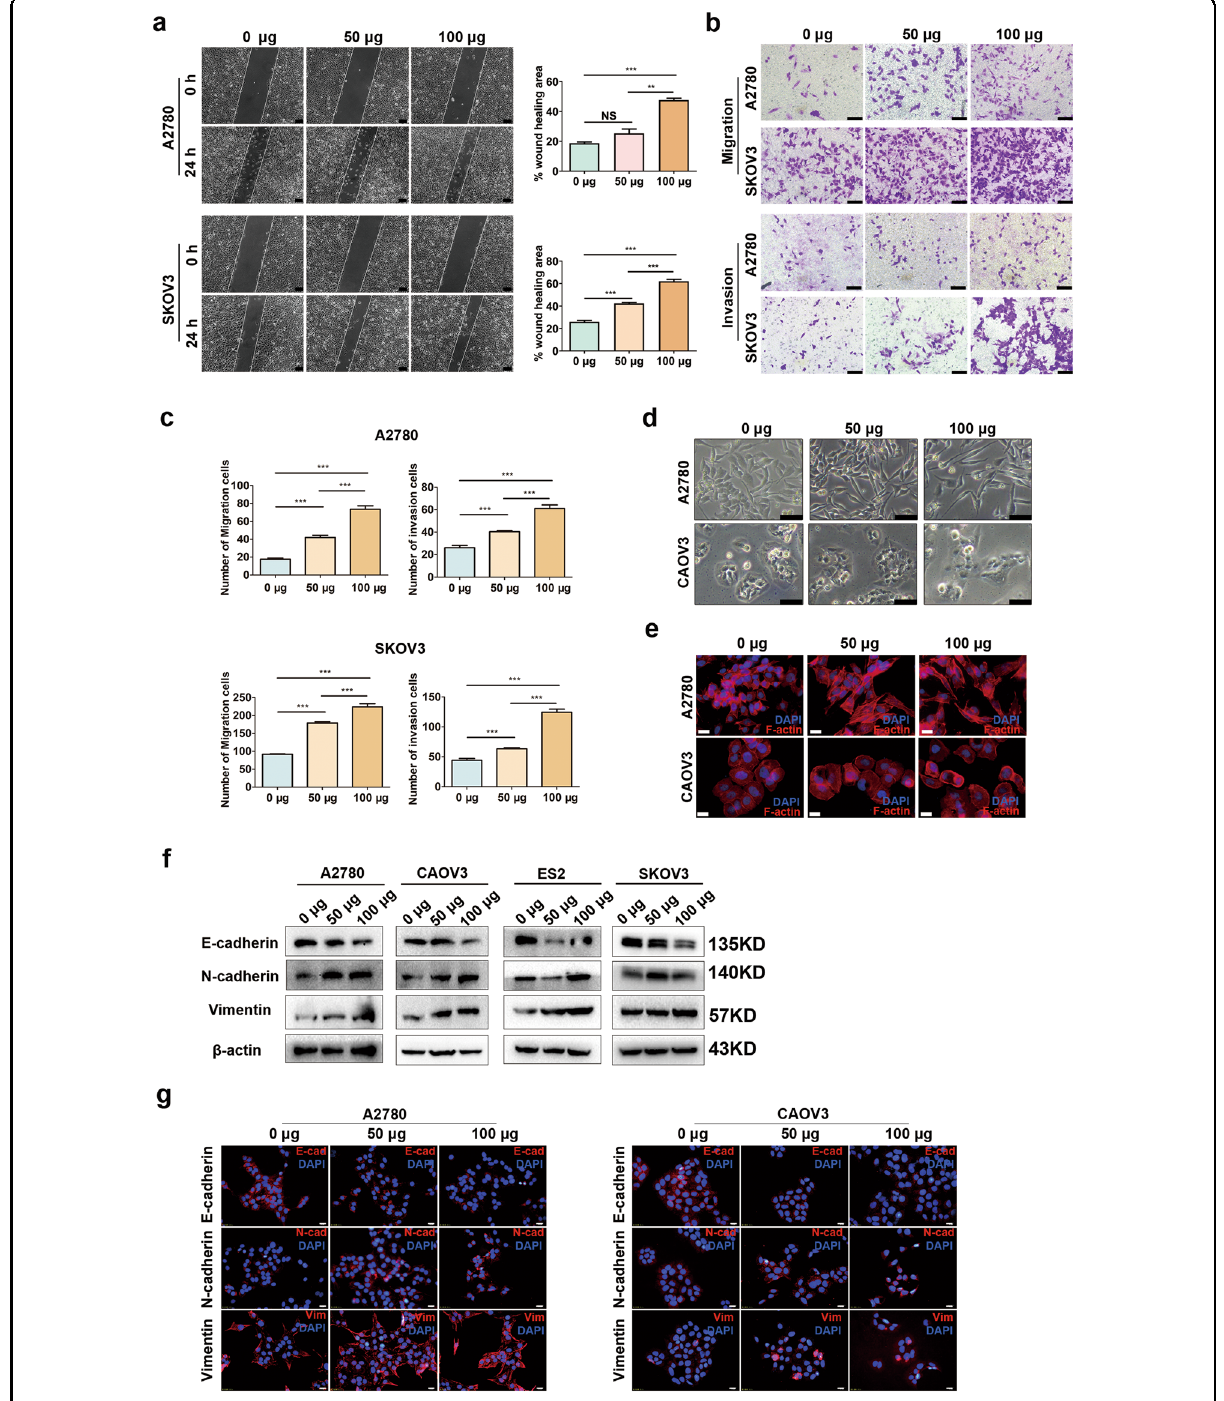
Fig. 2 ADEs promote EMT of ovarian cancer cells in vitro. A2780, CAOV3, ES2 and SKOV3 ovarian cancer cells were treated with 0 μ g, 50 μ g, and 100 μ g of #7 ADEs. a Representative images of wound-healing assays of A2780 and SKOV3 and the area of wound closure was measured. Scale bar, 100 μ m. b Representative images from migration and invasion assays of A2780 and SKOV3 cells. Scale bar, 100 μ m. c Invaded and migrated cells were counted and are shown as histograms. d , e Changes in the morphology of A2780 and CAOV3 cells were evaluated by microscopic observation and F- actin staining. Scale bar, 100 μ m ( d ), Scale bar, 20 μ m ( e ). f Western blot analysis of E-cadherin, N-cadherin and Vimentin expressions in A2780, CAOV3, ES2 and SKOV3 cells. g Immuno fl uorescence analysis of E-cadherin, N-cadherin, and Vimentin in A2780 and CAOV3 cells. Experiments were performed in at least triplicate, and the results are shown as the mean ± s.d. values. Student ’ s t test was used to analyze the data (NS, not signi fi cant; * p < 0.05; ** p < 0.01; *** p < 0.001). Scale bar, 20 μ